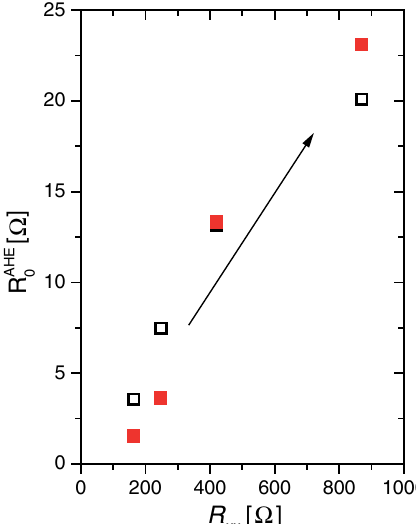
FIG. 9. R AHE 0 obtained at 2 K as a function of the residual resistance R xx revealing a linear relationship. Open and closed symbols indicate measurements repeated using different exper- imental setups (cf. Fig.